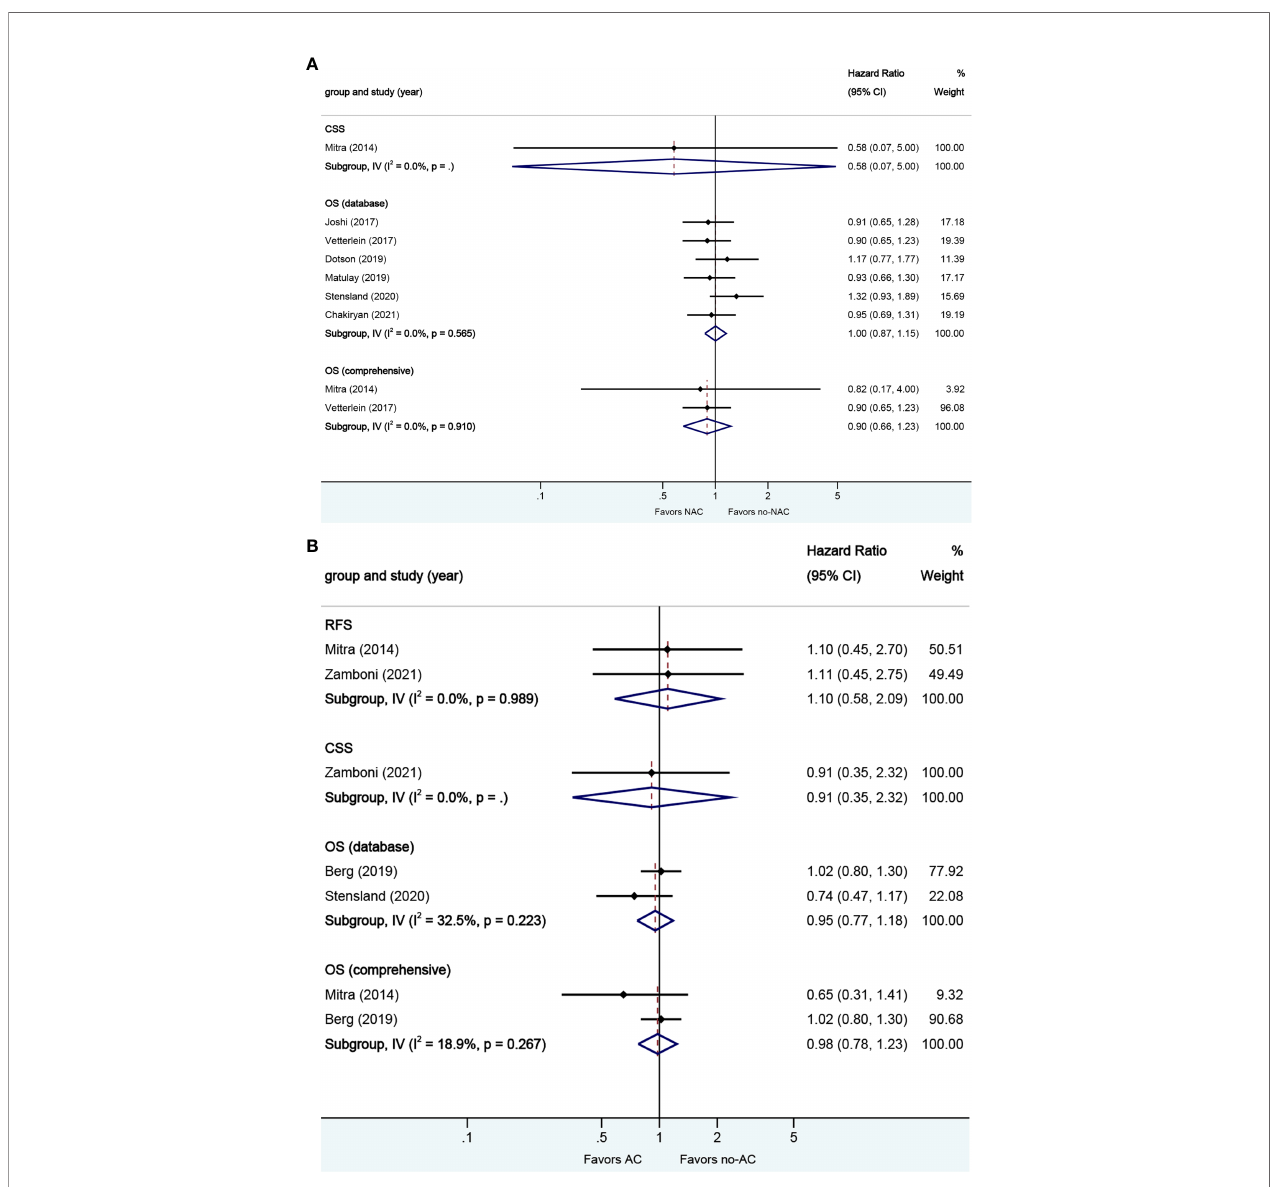
FIGURE 5 | Forest plots of studies investigating the association of chemotherapy with survival outcomes in squamous variant histology. (A) neoadjuvant chemotherapy; (B) adjuvant